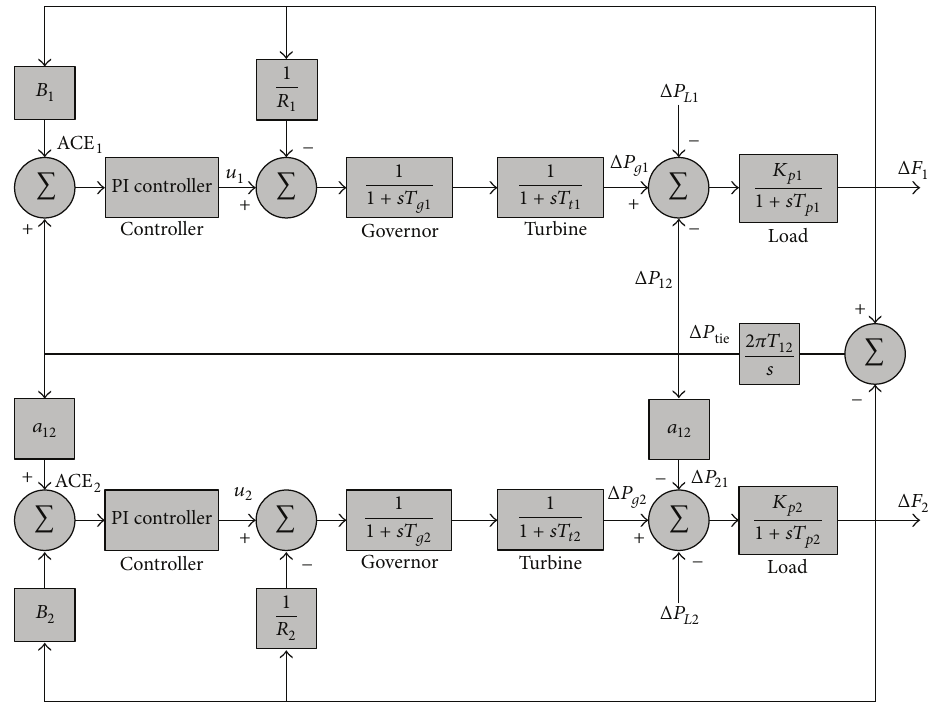
Figure 1: Transfer function model of two-area nonreheat thermal interconnected